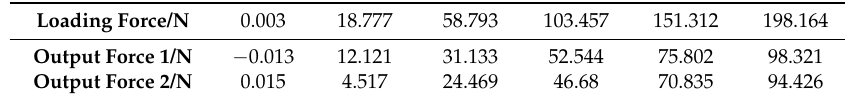
Table 4. Experiment 4 (the weight is 176.1 kg).